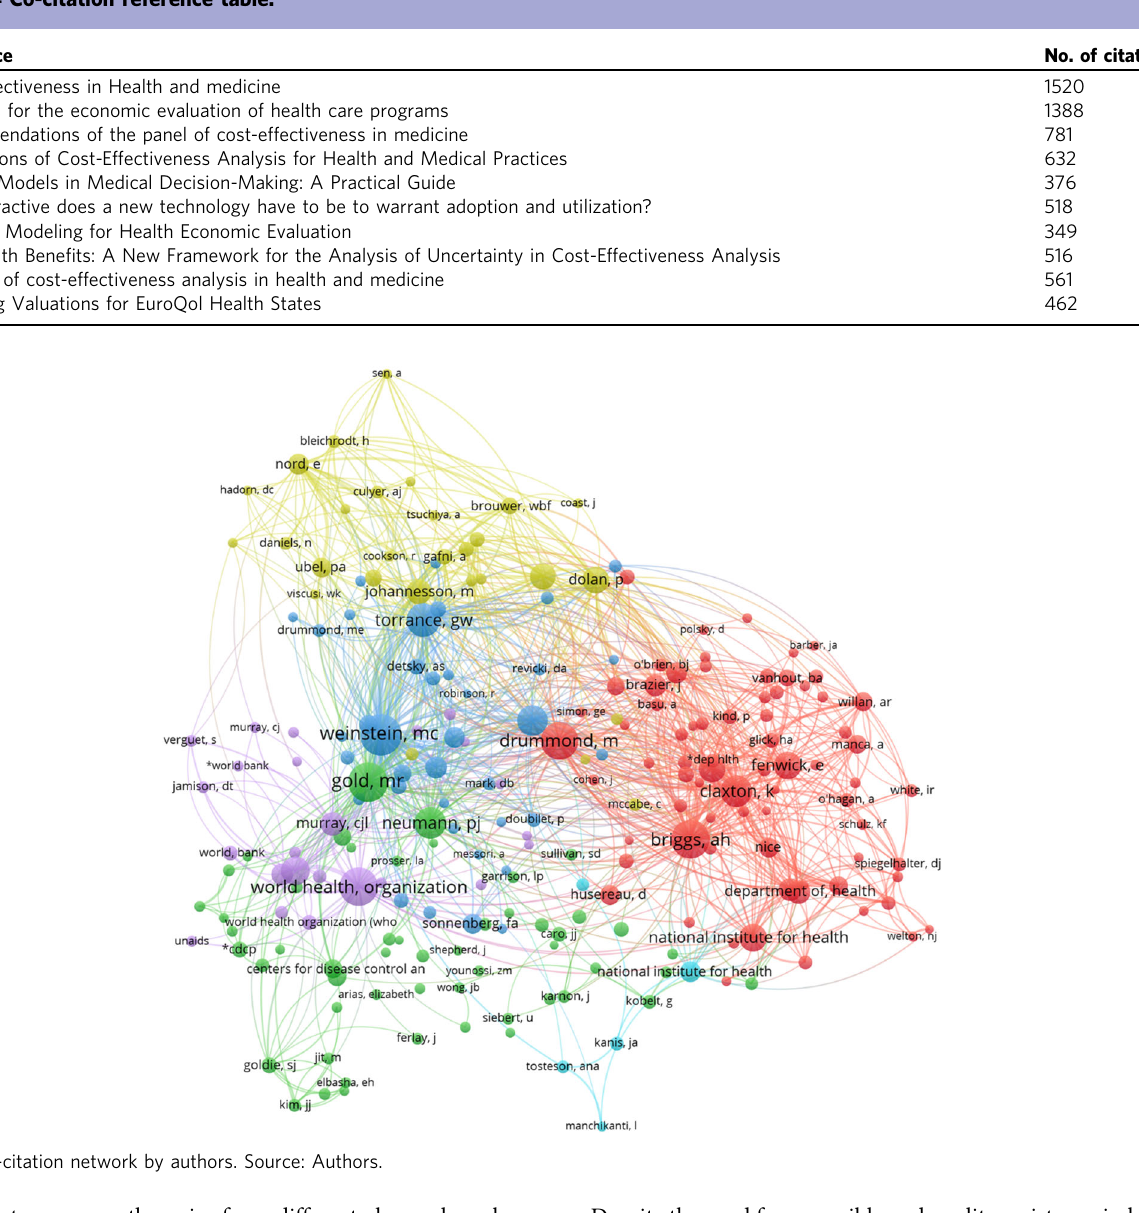
Table 4 Co-citation reference table.